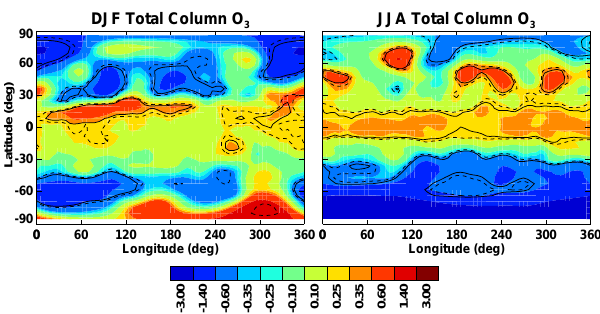
Fig. 18. Run mean, ensemble mean difference (%) between the two ensembles shown in Fig. 14 for total column